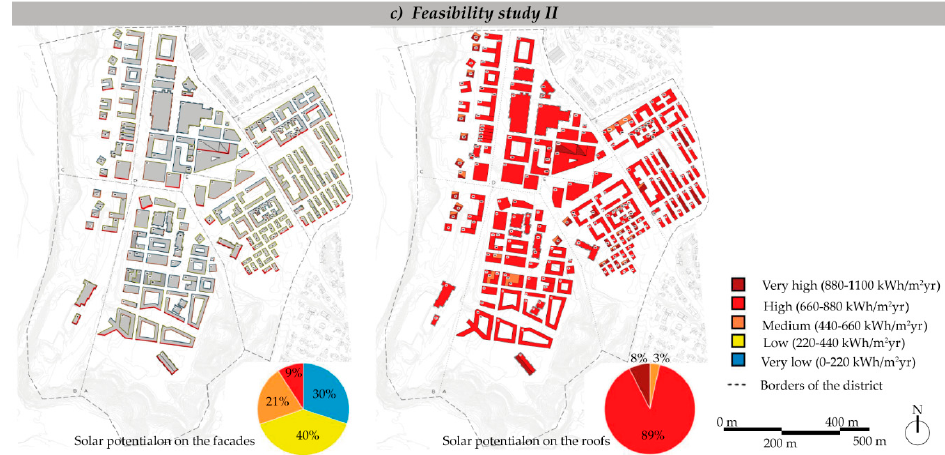
Figure 11. Solar map of the façades and roofs for the existing situation and the two feasibility studies.